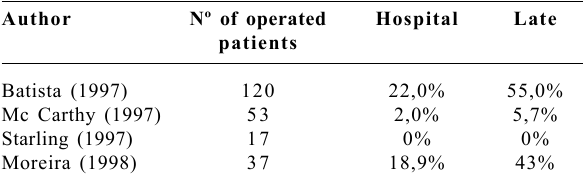
Table 3. Post-operative mortality (selected series)